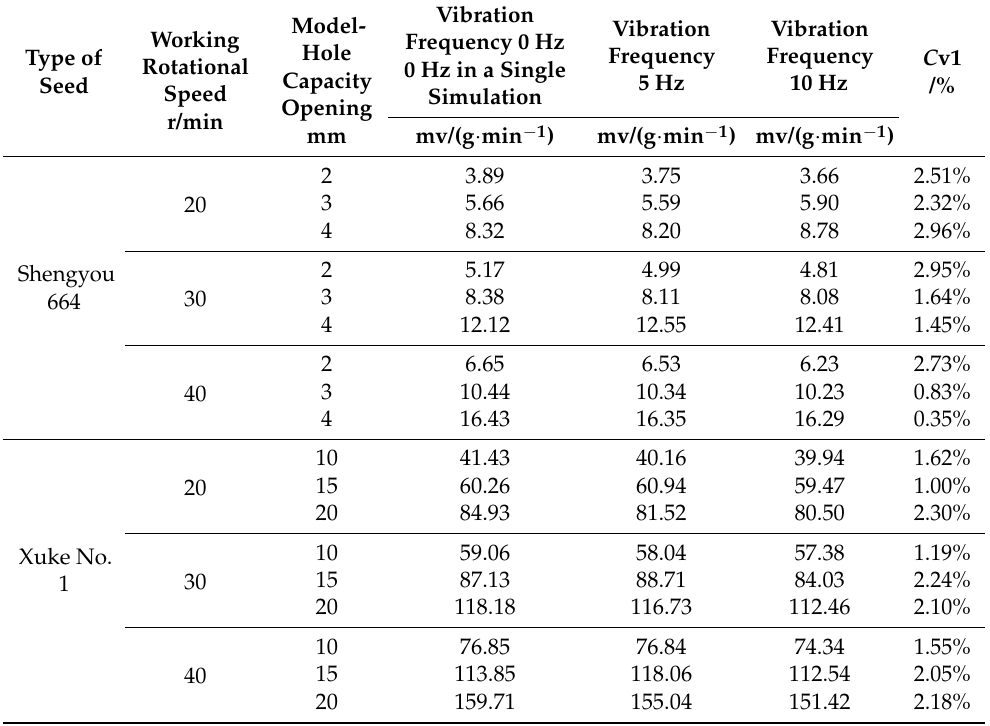
Table 6. Influence of vibration frequency on seed metering device performance of model-hole-wheel for both wheat and